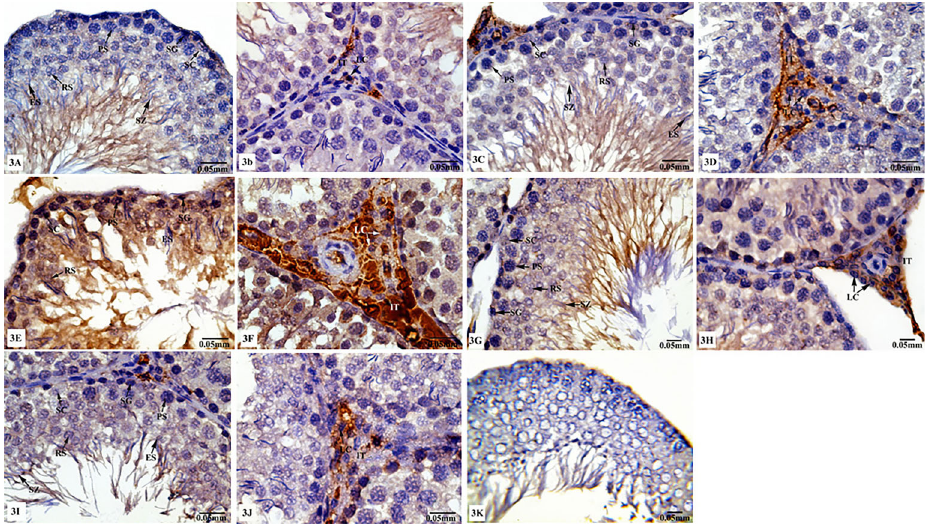
Figure 3. Photomicrographs of testicular tissues of control and experimental animal groups stained for P53 immunoreactivity. A and B , control group; C and D , sham group; E and F , taxol (TXL)-treated group; G and H , melatonin (MLT)-treated group; I and J , MLT + TXL- treated rats. There was no staining on the negative control sample ( K ). SC: Sertoli cells; SG: spermatogonia; PS: primary spermatocytes; RS: rounded spermatids; ES: elongated spermatids; LC: Leydig cells; IT: interstitium. Scale bar: 0.05